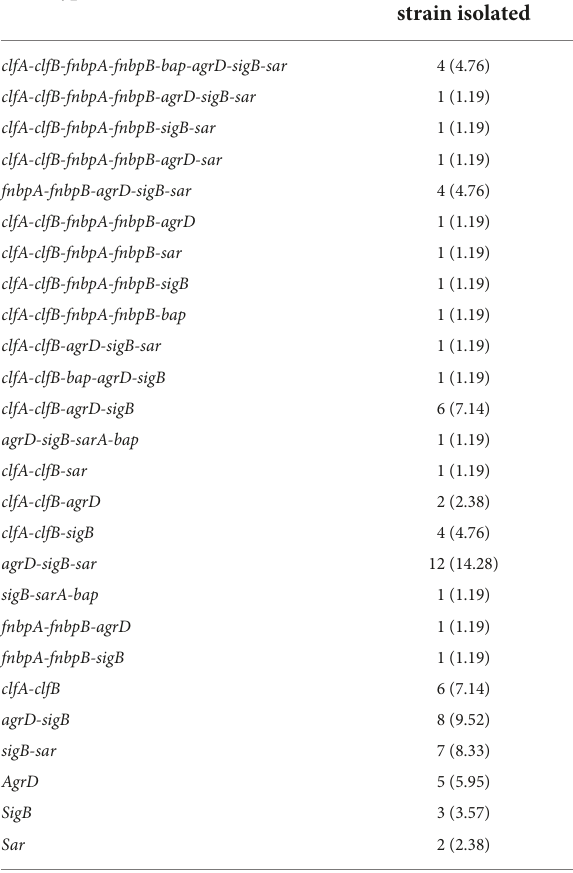
TABLE 1 Frequency of agrD , sar , sigB, and adhesin genes in Staphylococcus aureus isolates from food contact surfaces (FCSs) in the dairy